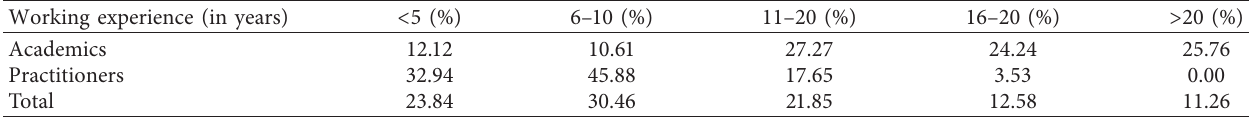
Table 3: Questionnaire survey respondents’ work experience.